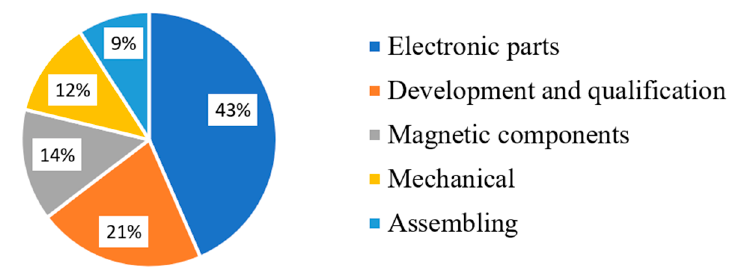
Figure 1. The contribution of each part of the manufacturing process for a 15 kW PV inverter and French manufacturer.